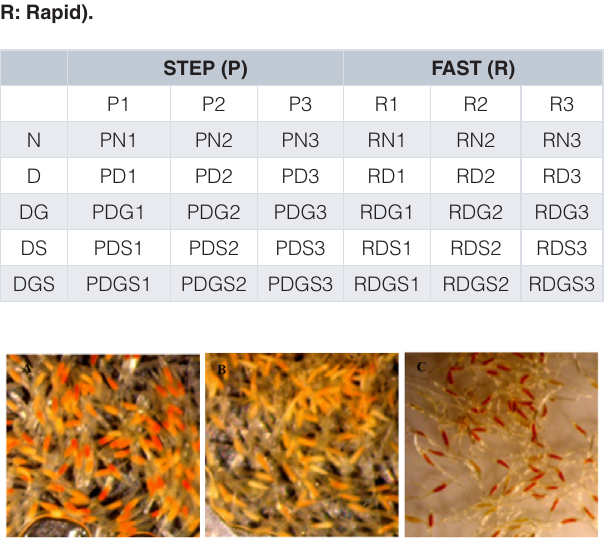
Table 2. Experimental design, testing orchid seeds cryopreservation - design 2x5 with three repetitions, Symbols